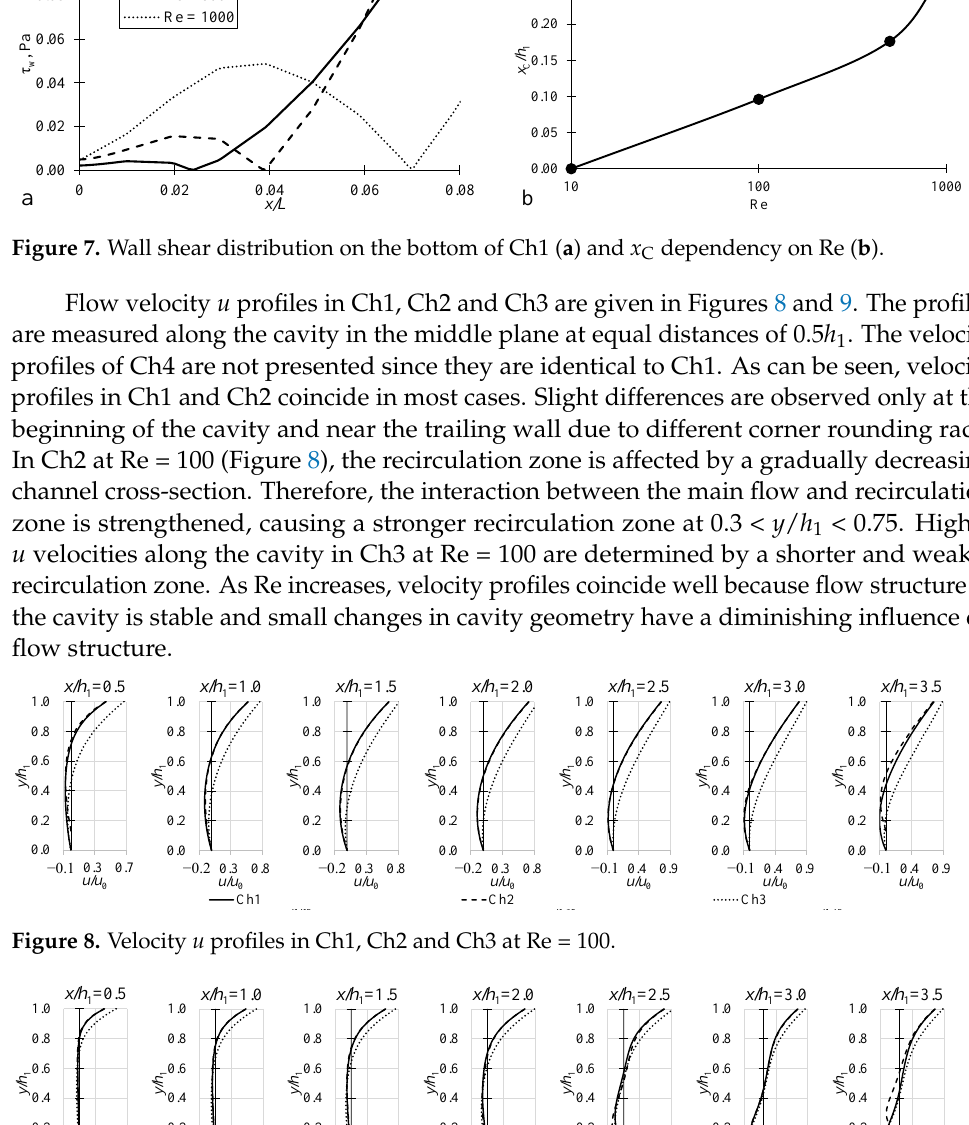
Figure 6. Static pressure contours and velocity streamlines in Ch1, Ch2 and Ch3 at Re = 10, 100 and 1000.